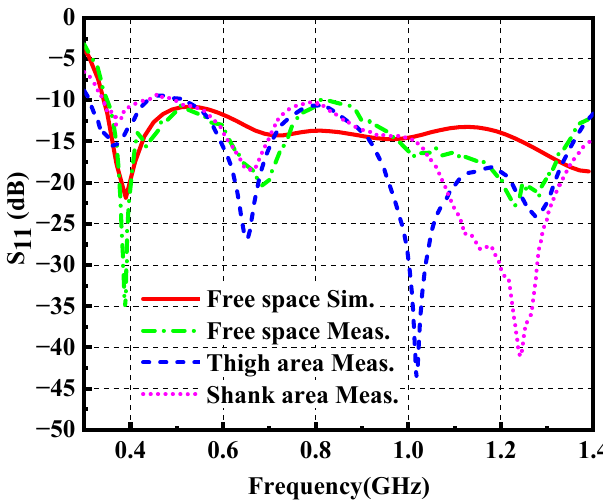
Figure 15. The simulated and measured reflection coefficient of the proposed antenna.